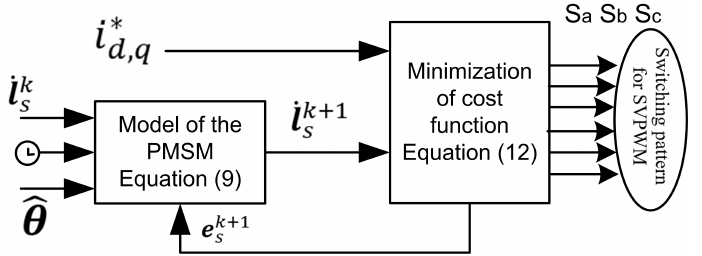
Figure 2. Finite Control Set-Model Predictive Control (FCS-MPC) internal